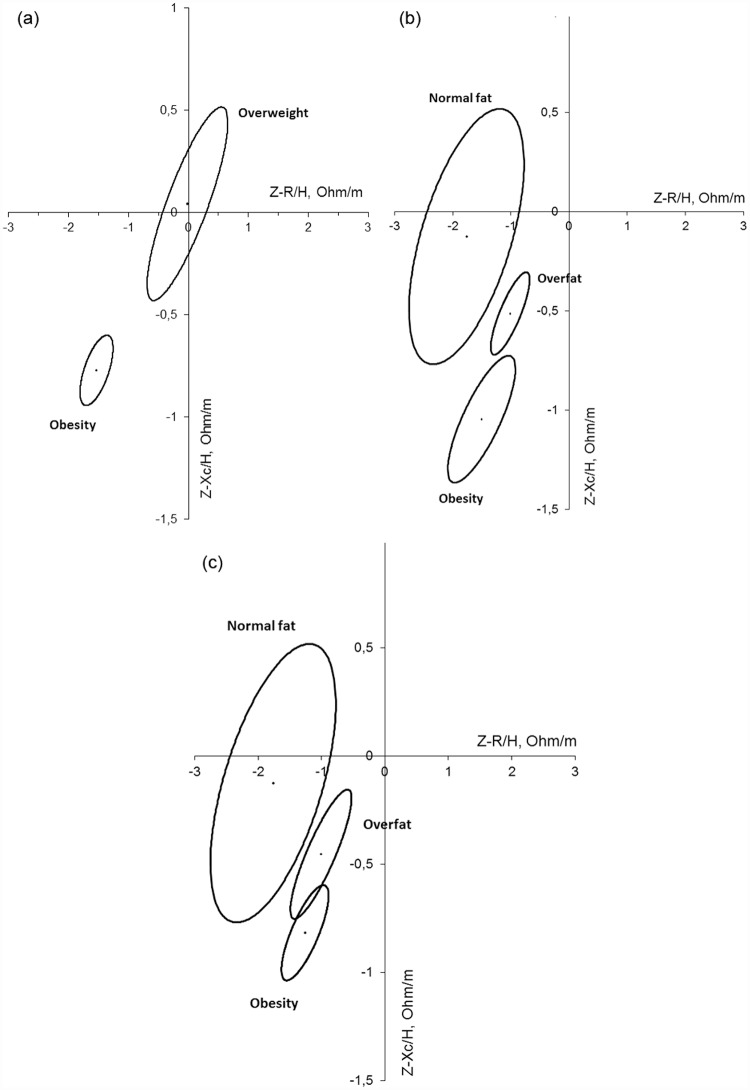
Confidence ellipses of the total sample based on the nutritional classification established form the Z-scores (a) of BMI, (b) of Z-%FM (ranked with the statistic criteria), and (c) of the Z-%FM (ranked with the IOTF criteria).(a) p<0.001 obesity vs. overweigth. (b) p<0.001 between groups. (c) p<0.001 nornal fat vs. the rest; p = 0.036 overfat vs. obesity.